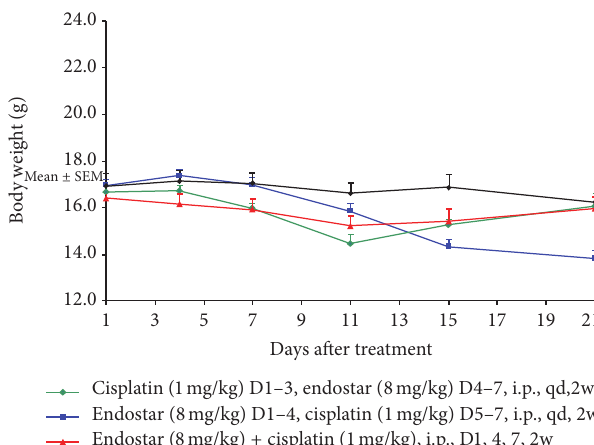
Figure 1: The differences in weight changes in nude mice among the fourtreatmentgroupsaspresentedbytherepeatedmeasuresprocess of the general linear